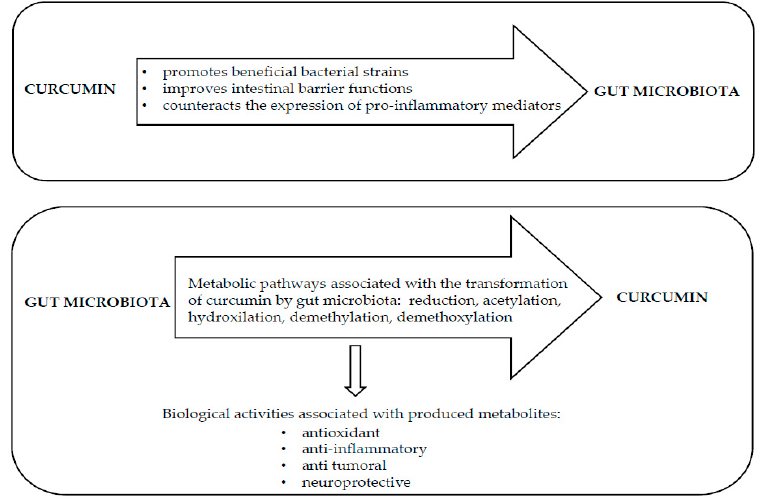
Figure 2. Reciprocal interaction between curcumin and gut microbiota.